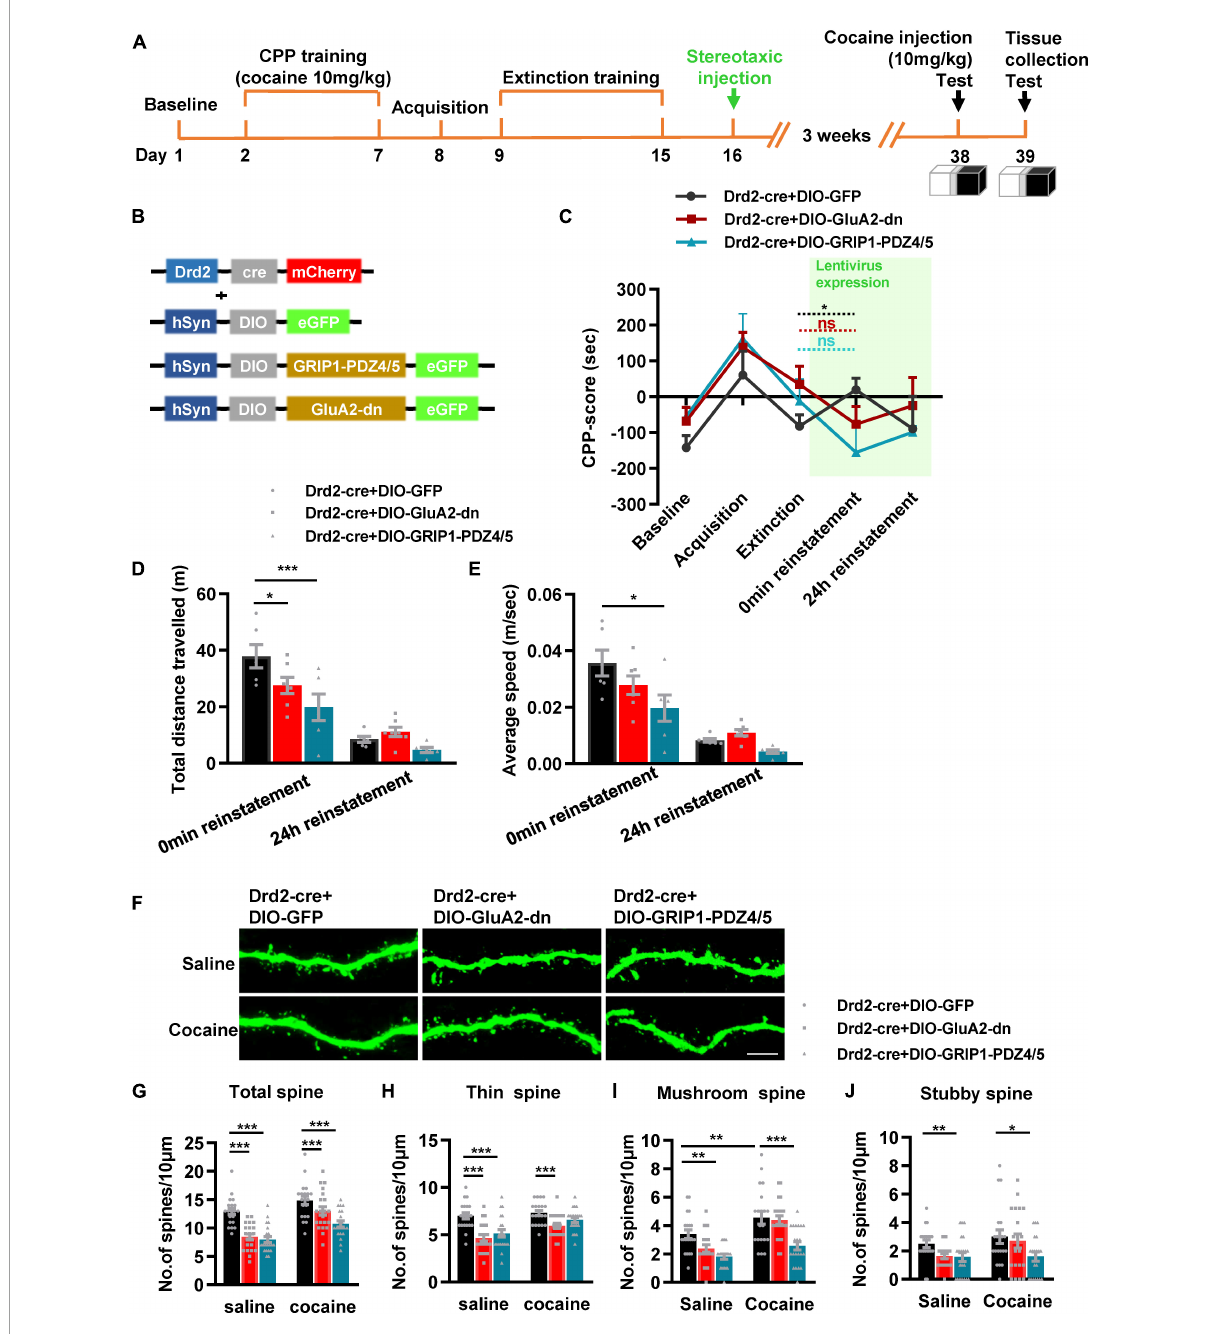
FIGURE8 Interference of GRIP1 and GluA2 interaction in D2-MSNs blocks cocaine-induced reinstatement and deceases spine density of D2-MSNs. (A) Experimental design for the behavioral tests and spine analysis. Three-compartment biased CPP models were used. (B) Viral vectors used to interfere with the interaction of GRIP1 and GluA2 in D2-MSNs. (C) GluA2-dn and GRIP1-PDZ4/5 expressed in D2-MSNs blocked cocaine-induced reinstatement. (D,E) Total distance traveled and average speed during 0 min reinstatement. (F) Representative images of GFP-labeled dendrites. (G–J) The statistical data for stubby spine, mushroom spine, thin spine, and total spine density. n = 20–30 dendrites obtained from 8–10 mice per group. * P < 0.05, ** P < 0.01, and *** P < 0.001.